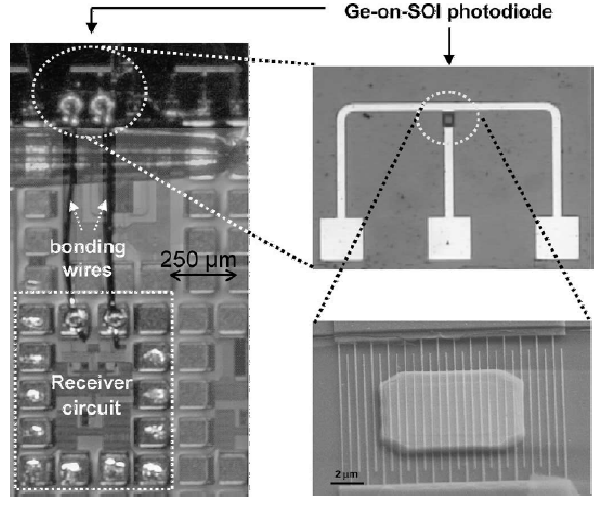
Figure 10. Optical micrograph showing a Ge-on-SOI photodiode wire-bonded to a high-gain CMOS IC. High-magnification optical and SEM micrographs of the photodiode are also shown. From